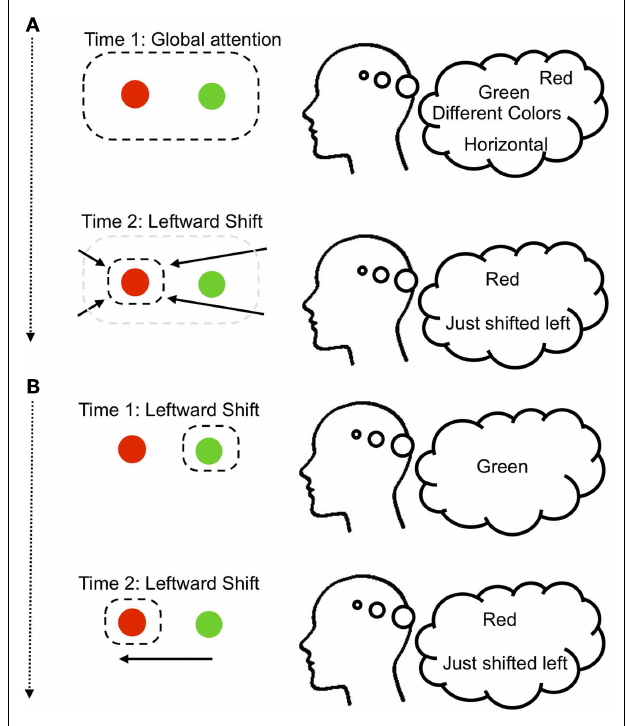
FIGURE 1 |Two variants of the visual spatial relationship judgment model from Franconeri et al. (2012). (A) When first encountering a pair of objects, we might select both in a global fashion, resulting in activation of those object identities in the ventral visual stream, perhaps along with other information such as the fact that they differ, or are horizontally arranged. Critically, within this global attentional state we do not know the relative positions of each object. Shifting the spotlight of attentional selection to the left would allow the conclusion that the red object was on the left of the arrangement. (B) A second way to encode relations would be to isolate one object (e.g., green), and then shift attention to the other object (e.g., red), recording the direction of the shift (e.g.,